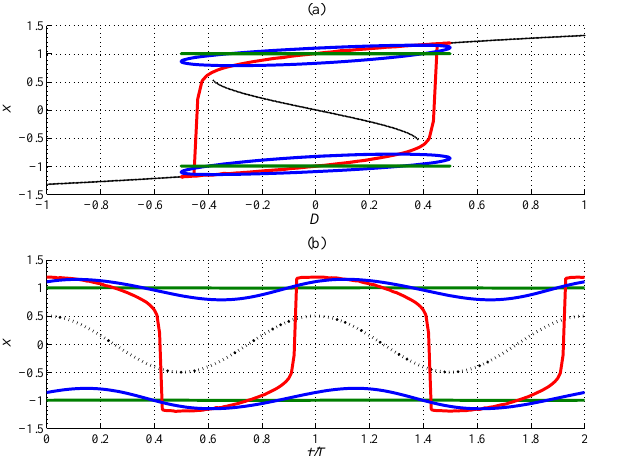
Figure 1. The dynamics of the system described by Eq. (11) in three different timescale regimes. Forcing parameters are set to D m = 0, D a = 1 / 2. In the upper panel system state x is plotted against D ( t ). The black lines are the nullclines and the coloured lines are the sys- tem responses for different periods of forcing. In the lower panel x is plotted against the number of cycles, t/T , once the system has reached a steady state. The dotted line is the forcing, D ( t ) while the coloured lines are the system responses. The red line is for the slow forcing limit, τ (cid:28) T , T = 100 π so ωτ ≈ 1 / 100. As the sys- tem timescale is much faster than the change in the forcing, the system essentially “sticks” to the fixed points until they become unstable at the bifurcations and jump to a different attractor. One can regard the system response in two different ways: (i) a single periodic attractor giving relaxation oscillations in a monostable re- gion. (ii) Tipping between point attractors by crossing local bifur- cations in a bistable region. This tipping causes the dynamics to be very nonlinear. The green line is the fast forcing limit, T (cid:28) τ , T = π/ 100 so ωτ ≈ 100. There are two possible stable attractors for this set of values. As the system timescale is much slower than the change in the forcing, the system essentially remains static and all the dynamics come from the forcing itself. Although it is hard to see in the figure due to the small amplitude system response, the lag relative to the forcing is 1 / 4 of a cycle and the dynamics are ap- proximately linear. The blue line is the intermediate regime, τ ∼ T , T = π so ωτ ≈ 1 and there are two possible stable attractors for this set of values. As the system timescale is approximately the same as the period of the forcing, the system response is a competition be- tween the system’s tendency to decay towards the nullcline and the forcing pushing it away setting up a stable orbit. Notice that there is some phase lag and the dynamics look approximately